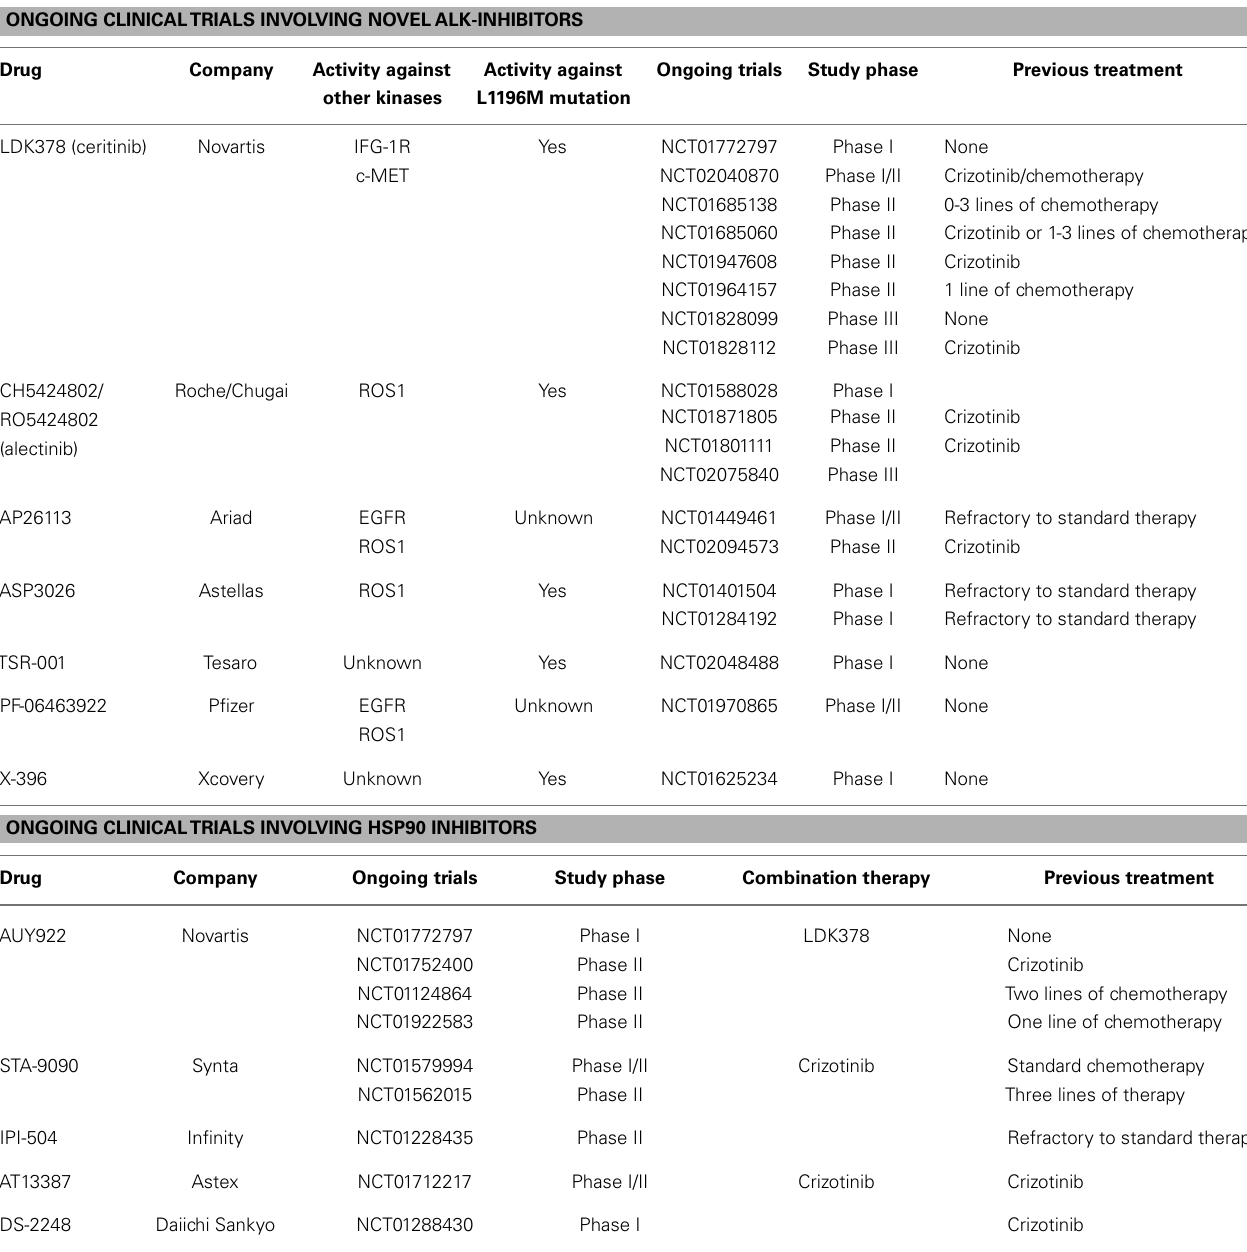
Table 1 | Ongoing clinical trials involving novelALK- and HSP90-inhibitors in NSCLC . ONGOING CLINICALTRIALS INVOLVING